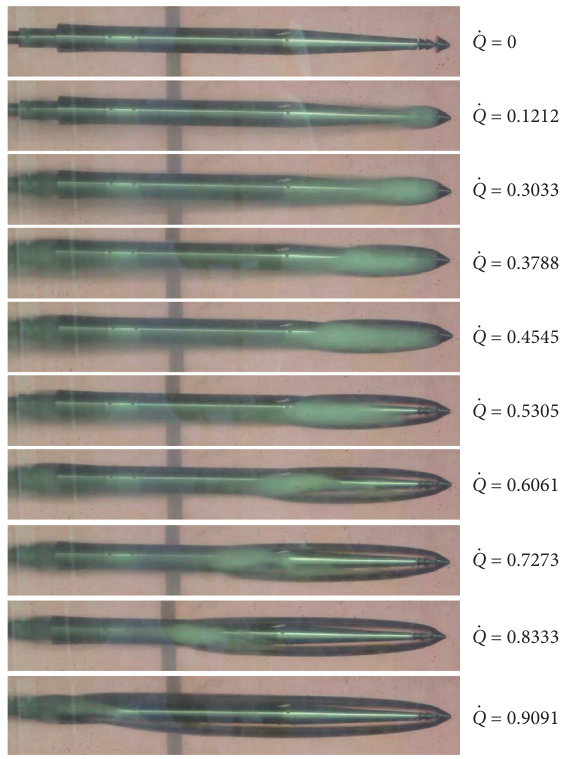
Figure 12: Photographs of ventilated cavities at water tunnel.